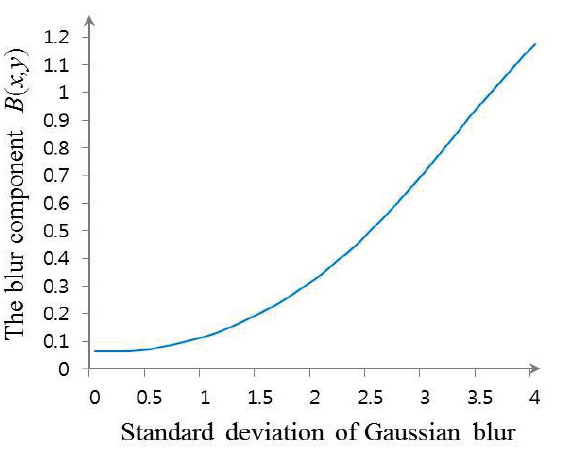
Figure 7. The blur size ( , ) B x y calculated with neighbors in the size of 21 × 21. Estimated values of ( , ) B x y share adjacent intervals to select one of multiple TCLS filters for practically viable implementation. In this paper, the sharing step depends on the estimated values in